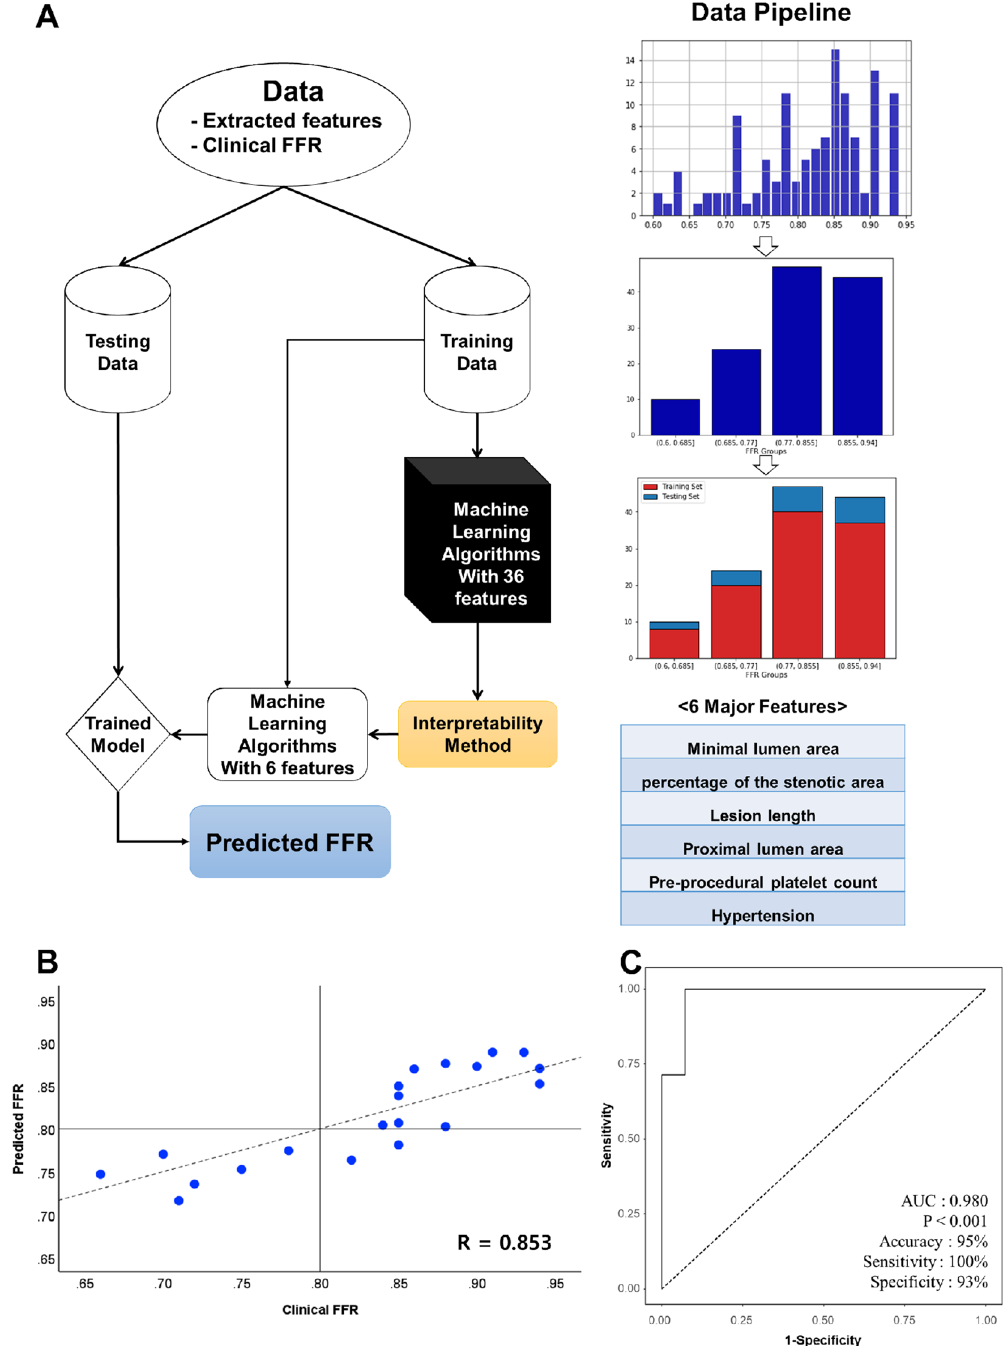
Figure 1. Optical coherence tomography-based machine learning for predicting fractional flow reserve. ( A ) Flow chart of the proposed machine learning method. ( B ) Comparison between the clinical fractional flow reserve results and the predicted fractional flow reserve results by the Random Forest model in the testing set. ( C ) Receiver operating characteristic curve of machine learning-fractional flow reserve. FFR fractional flow reserve, AUC area under the